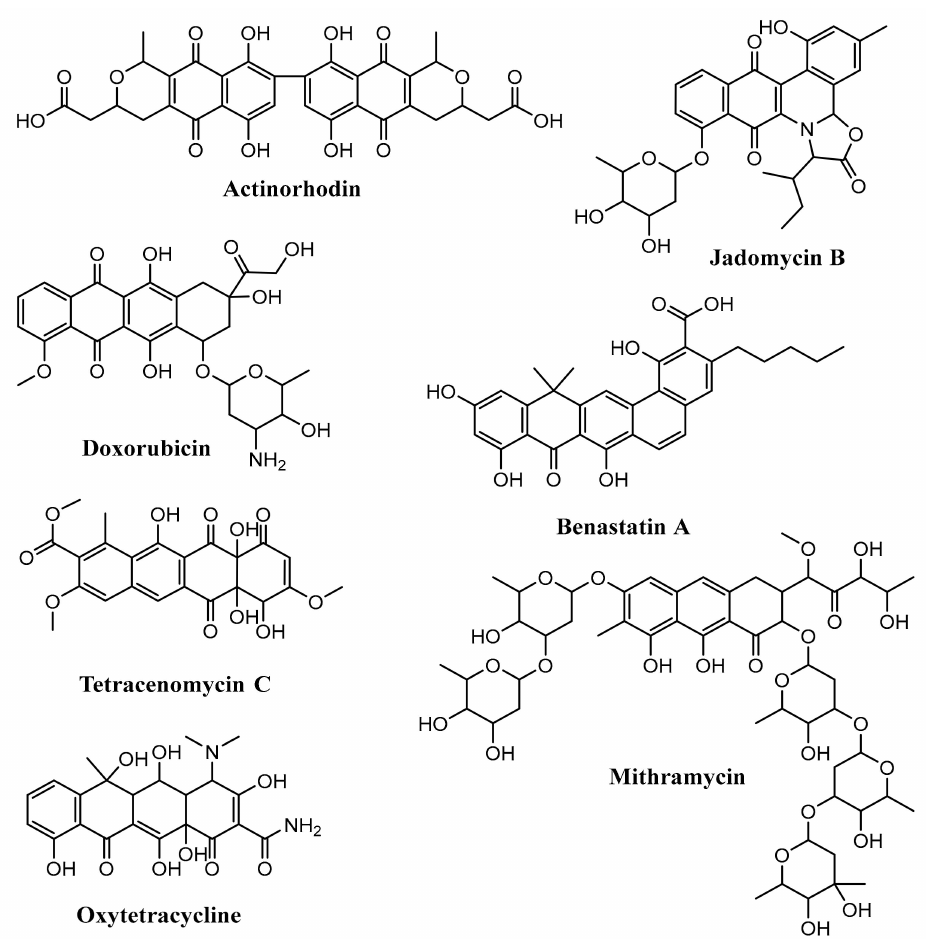
Figure 5. Some aromatic polyketides produced by Streptomyces